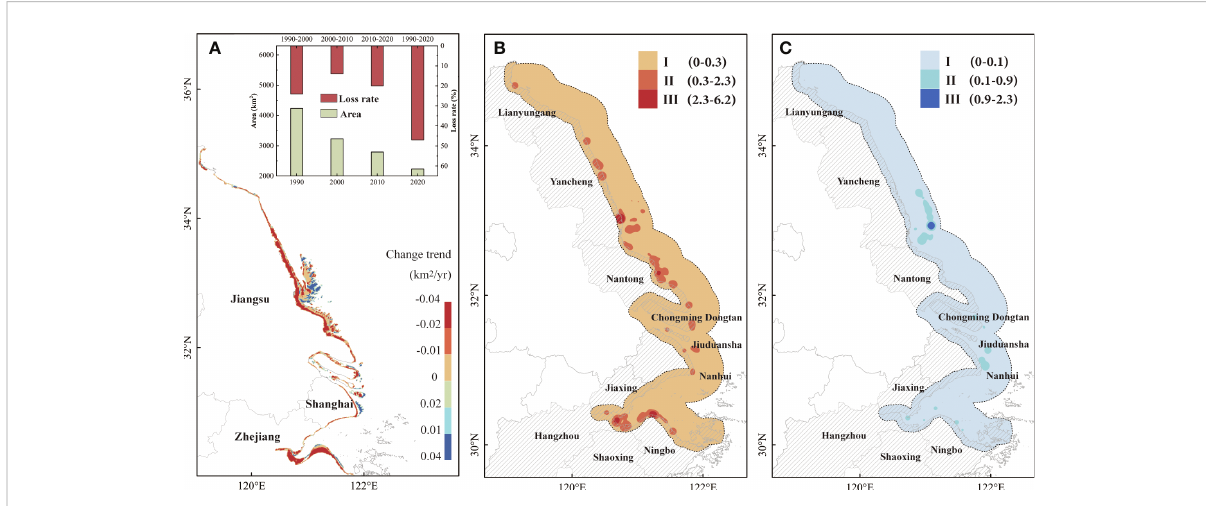
FIGURE 3 Distribution of tidal fl at dynamics in the study area. (A) Tidal fl at area changes. (B) Kernel density analysis of tidal fl at losses from 1990 to 2000. (C) Kernel density analysis of tidal fl at gains from 1990 to